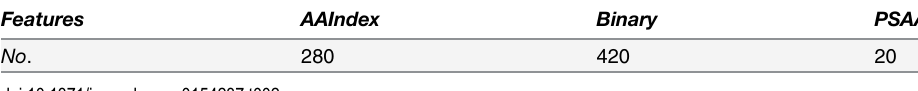
Table 2. The number of dimensions of three feature